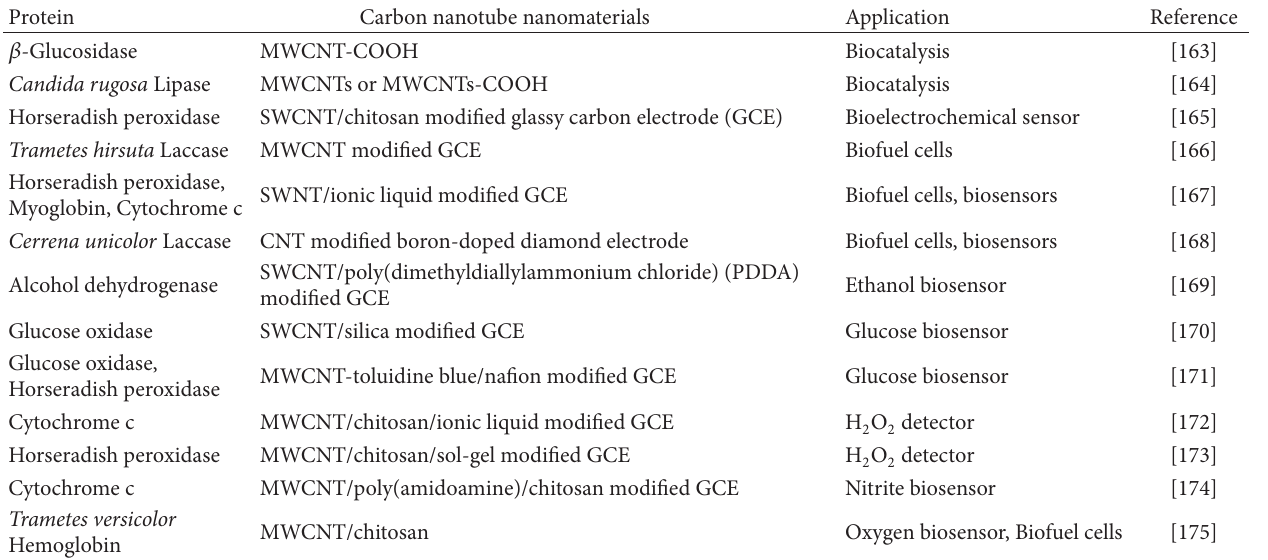
T 4: Applications of carbon nanotube-protein